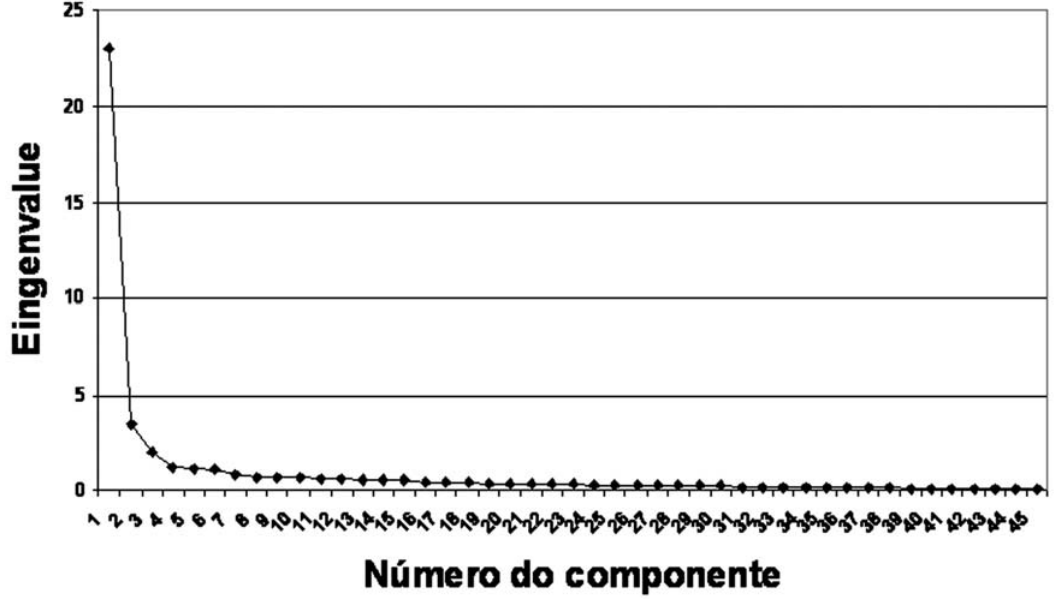
Figura 2. Scree Plot da Análise Fatorial da Escala Triangular do Amor de Sternberg